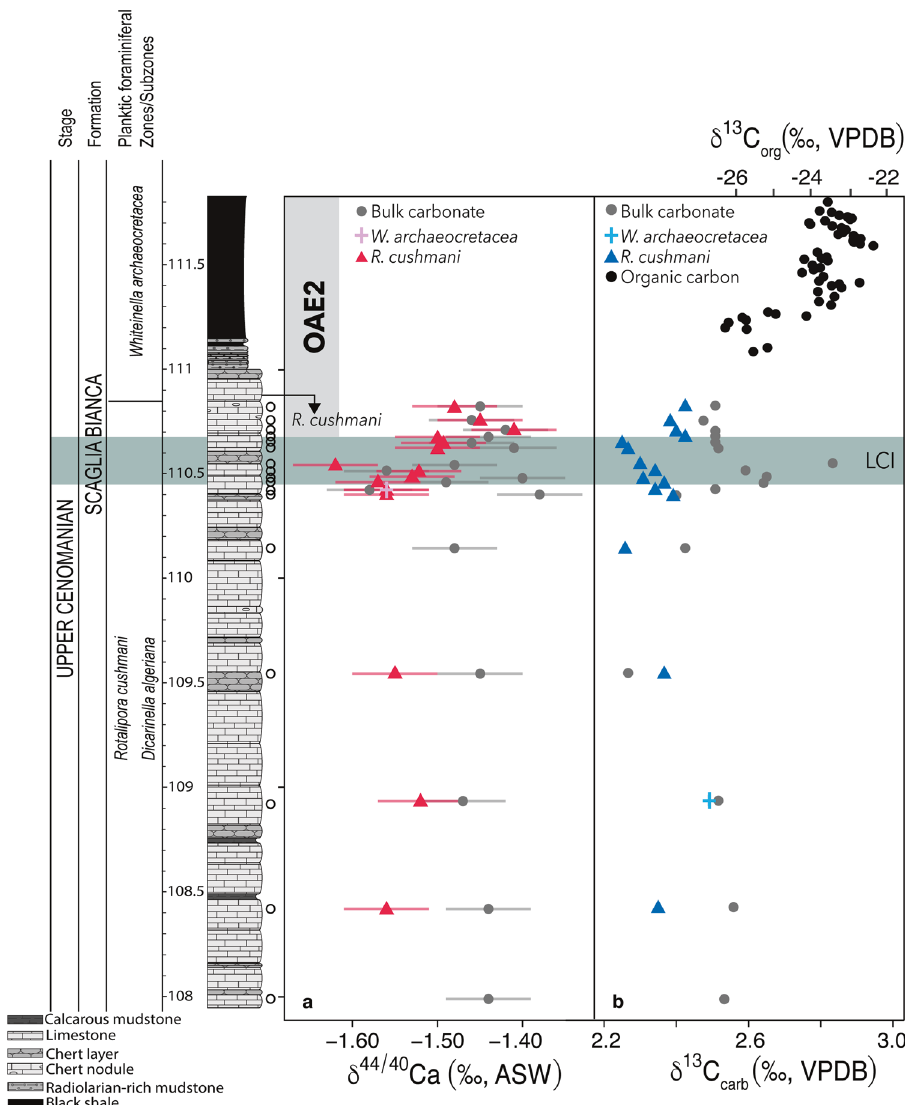
Fig. 1 Stratigraphic calcium and carbon isotope data from the Bottaccione section. Relative to stratigraphy of the Bottaccione section, a calcium isotope values ( δ 44/40 Ca) of planktic foraminifera Rotalipora cushmani (red triangles), Whiteinella archaeocretacea (pink cross), and bulk carbonate (gray circles) where the error bars correspond to the analytical external reproducibility of ±0.05 (2 σ SD ), and b carbon isotope values of carbonate ( δ 13 C carb ), including planktic foraminifera Rotalipora cushmani (blue triangles), Whiteinella archaeocretacea (blue cross), and bulk carbonate (gray circles). Oceanic Anoxic Event 2 is denoted by the positive δ 13 C org excursion 73 just below the black shale interval, here expressed at the Bonarelli Level. The last occurrence of R. cushmani is denoted by the downward pointing arrow. The open circles next to the stratigraphic column represent sample locations. LCI lower critical interval, ASW Atlantic Seawater; VPDB Vienna Peedee